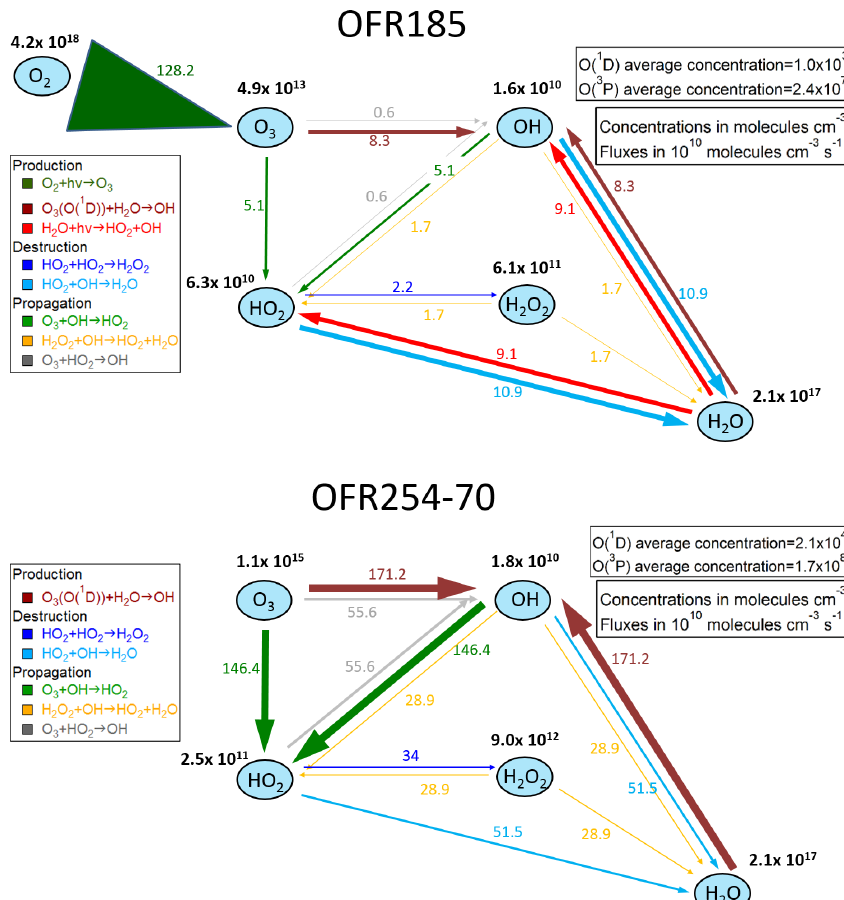
Figure 1. Schematics of main species and major reaction pathways for a case with medium H 2 O and UV, and zero OHR ext , for both OFR185 and OFR254-70. Species average concentrations (inmoleculescm − 3 ) are shown in black beside species names. Arrows denote directions of the conversions. Average reaction fluxes (in units of 10 10 moleculescm − 3 s − 1 ) are calculated according to the production rate, and shown on or beside the corresponding arrows and in the same color. Within each schematic, the thickness of the arrows is a measure of their corresponding species flux. Multiple arrows in the same color and pointing to the same species should be counted only once for reaction flux on a species. Note that all values in these schematics are average ones over the residence time, and not obtained from steady state. In the legend, reactions are classified as production, destruction, and propagation of HO x . Since the reactions involving O and H atoms are very fast, they are not shown